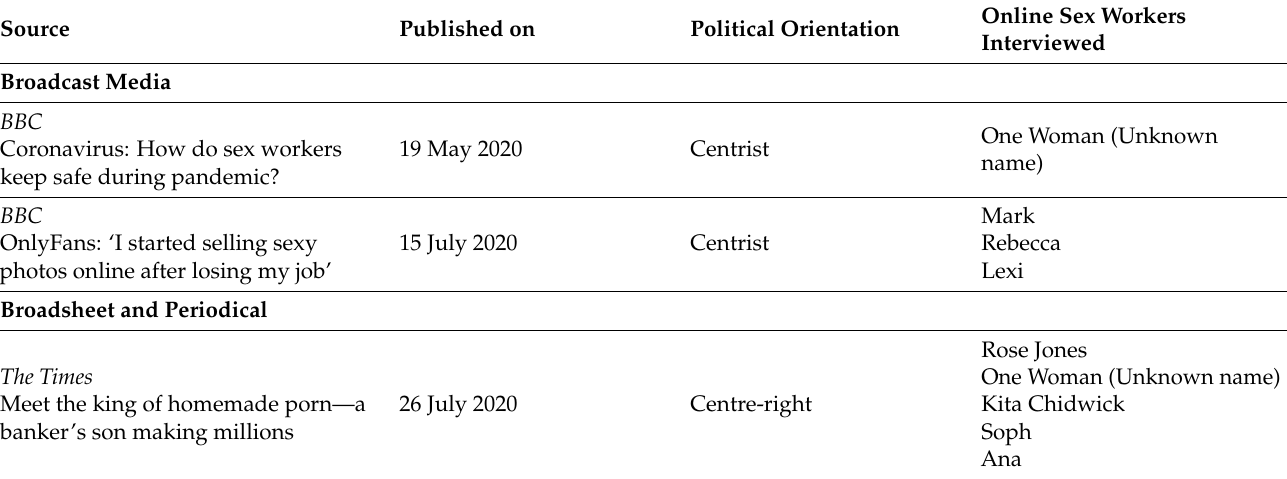
Table 1. Articles analysed in Study One, Online sex work from January 2020 to May 2021, Publication dates, Political orientation and Workers